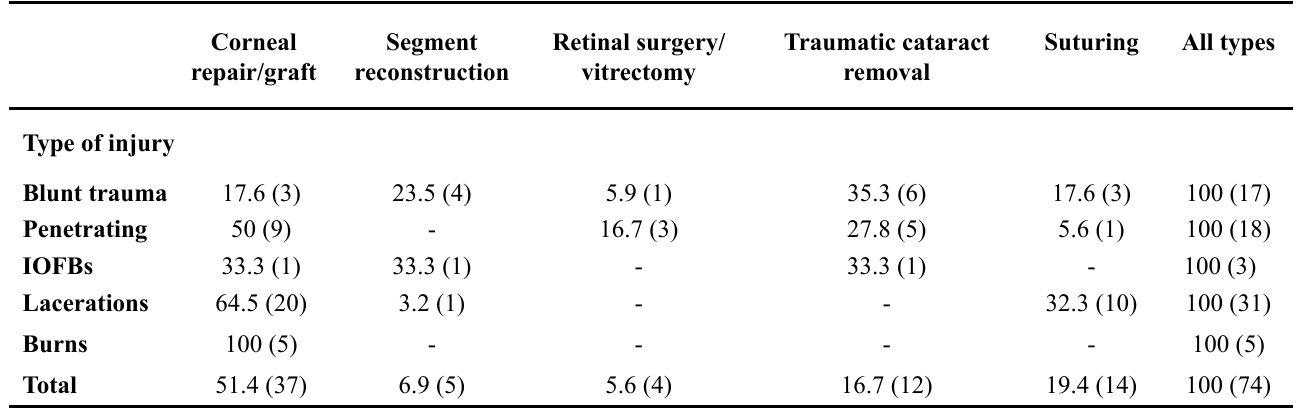
Table 2 . Types of injuries (in % and numbers ( n )) in relation to type of surgery for patients who had to undergo surgical intervention